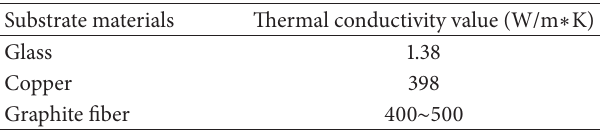
Table 3: Thermal conductivity value for glass, copper, and graphite